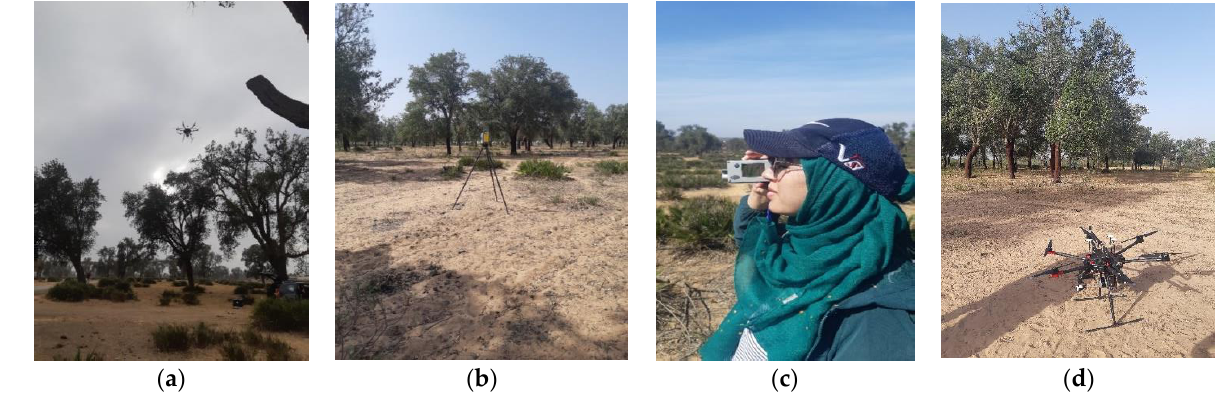
Figure 3. ( a ) ALS-UAV Data Acquisition; ( b ) Data acquisition with Trimble X7 scanner; ( c ) Tree height acquisition with Vertex Hypsometer ( d ) Velodyne VLP-16 Lidar sensor on Matrice 600 pro UAV.